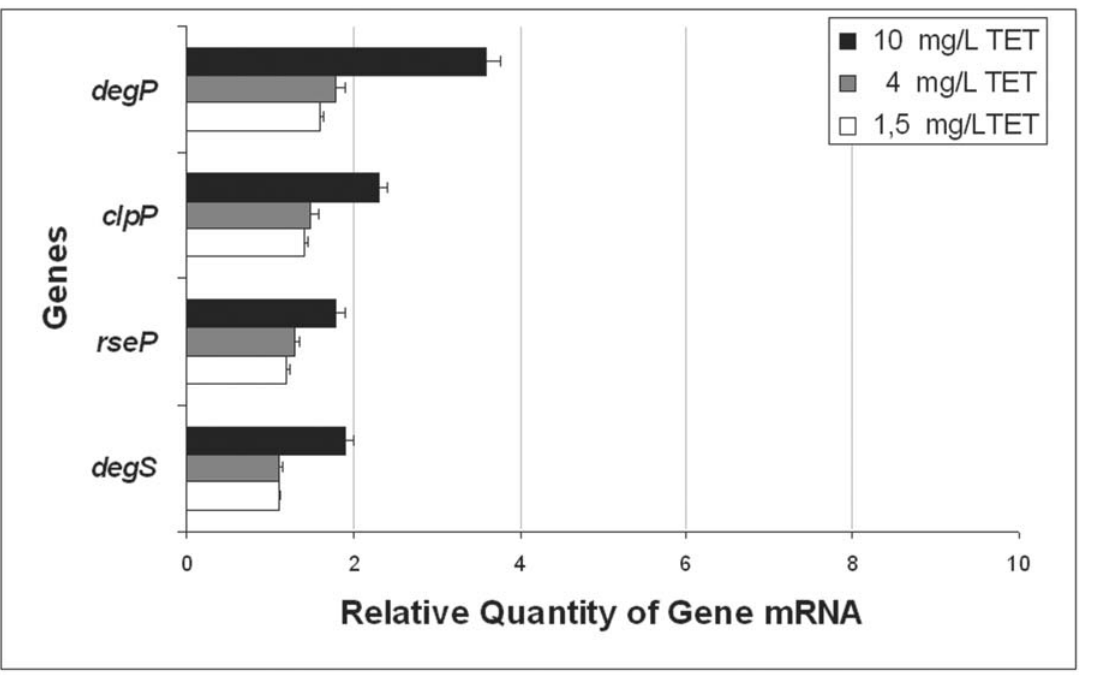
Figure 3. Relative quantification of the expression level of the protease genes. Data from three independent total mRNA extractions of E. coli AG100 physiologically adapted to increasing concentrations of TET compared to its parental non-induced strain grown in absence of TET as described in Materials and Methods. A ratio of 1 corresponds to no alterations in expression compared with untreated control cells. Values were corrected for standard deviation range.